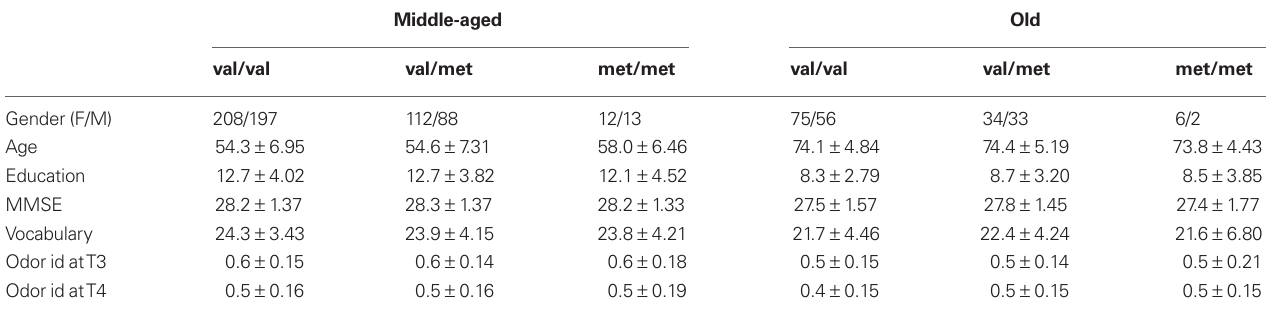
Table 1 | Sample characteristics. Descriptive data across age and genotype groups (mean ±